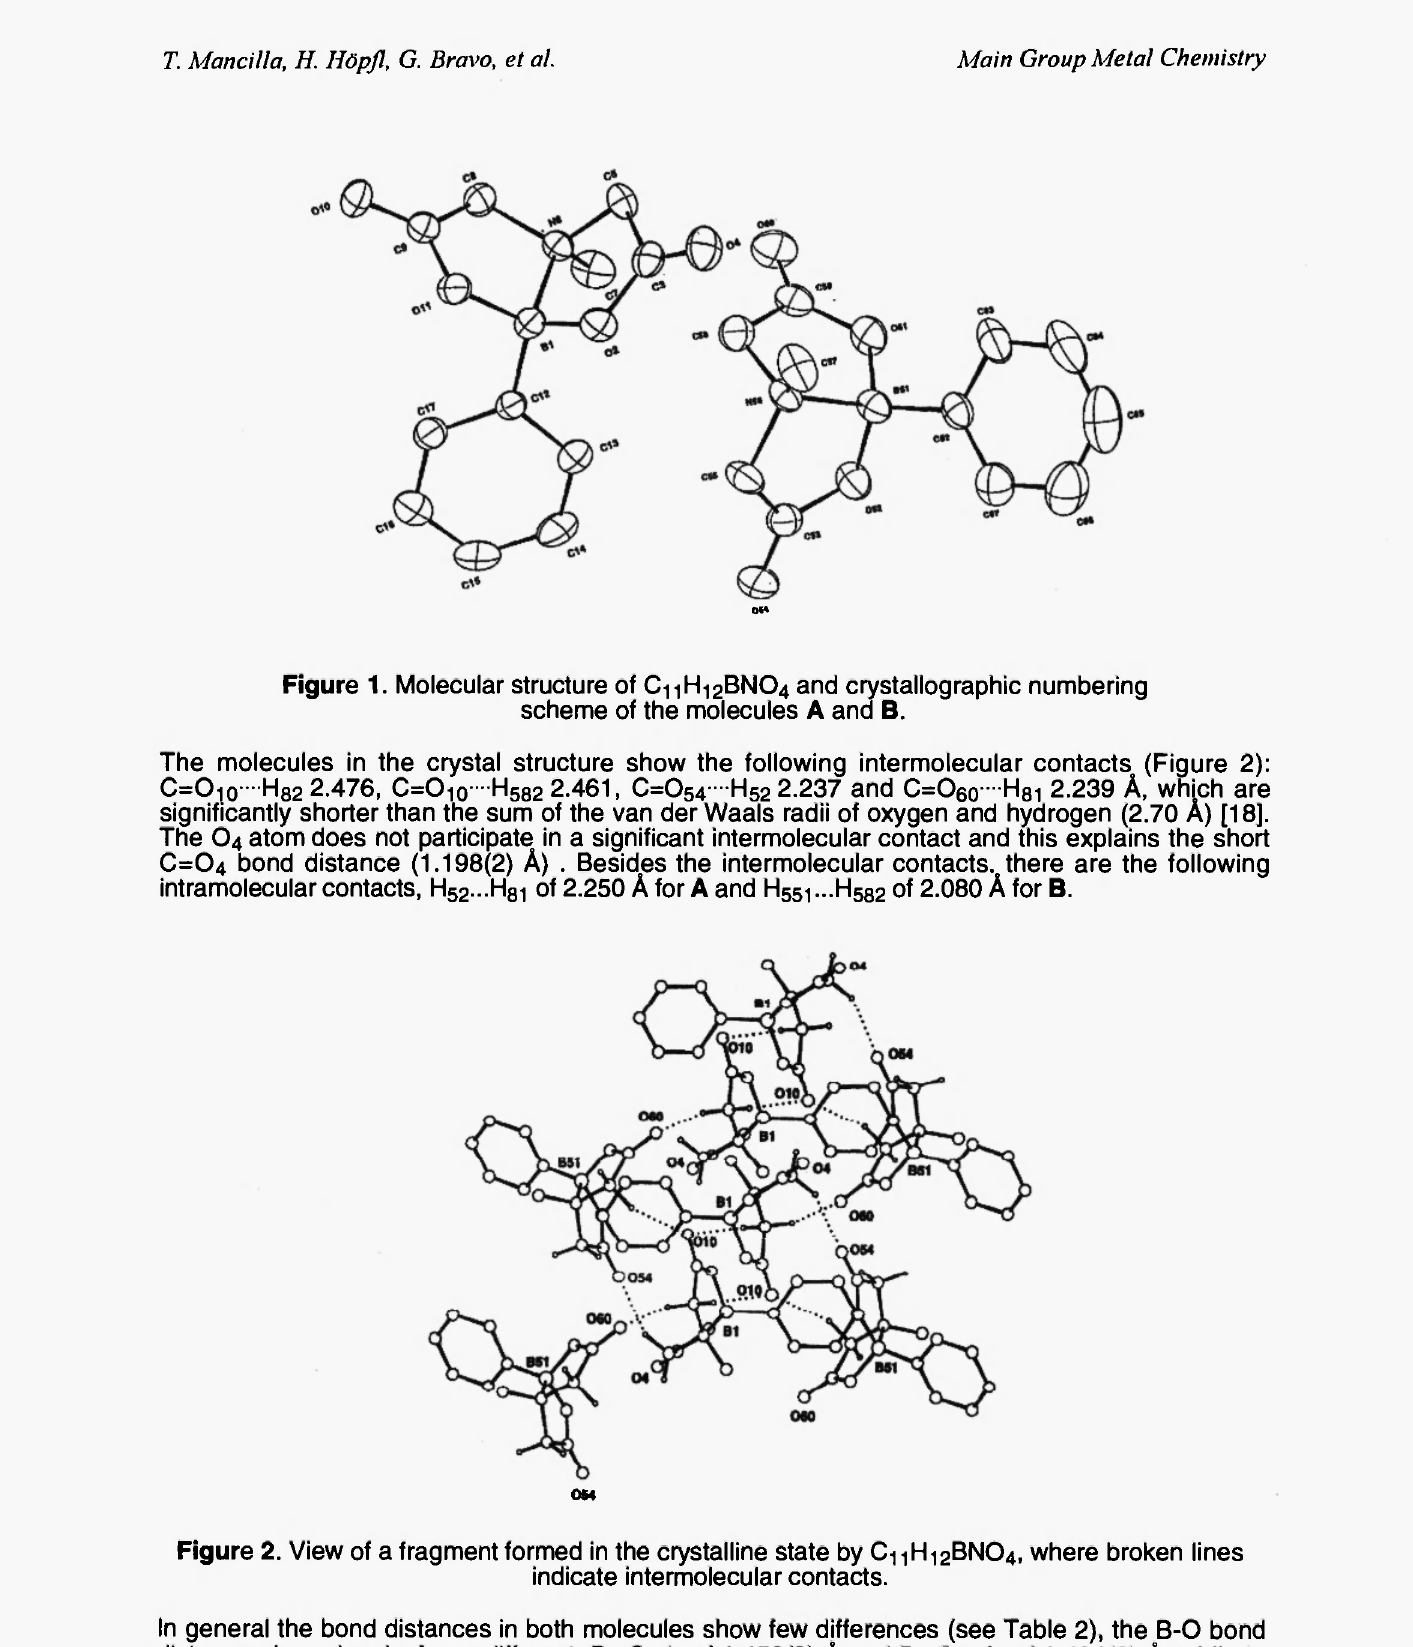
Figure 2. View of a fragment formed in the crystalline state by C11H12BNO4, where broken lines indicate intermolecular